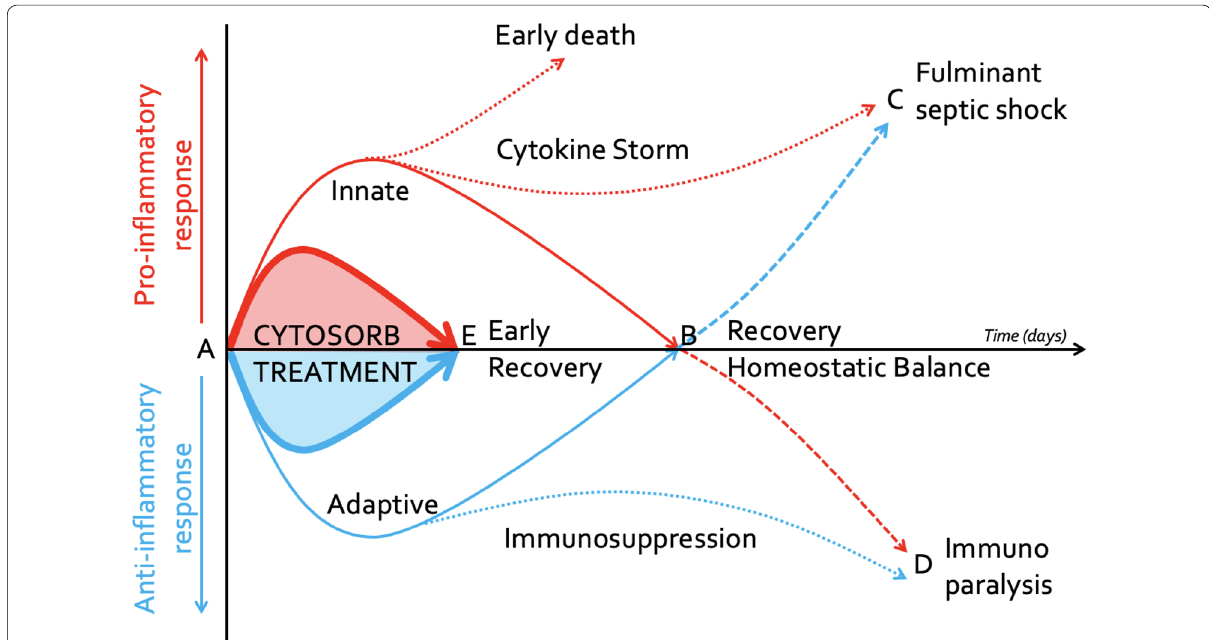
Fig. 1 Cytokine response after sepsis. Normal and abnormal immune response after an (infectious) insult (A). Recovery with regaining of the homeostatic balance occurs when pro‑inflammatory (solid red line) and anti‑inflammatory (solid blue line) mediators (B) return back to baseline levels. Early death or fulminant septic shock (C) can occur following early increased innate pro‑inflammatory response (cytokine storm, dotted red line) or after initial adaptive immunosuppression (dashed blue line). Immunoparalysis (D) can occur following early increased adaptive anti‑inflammatory response (immunosuppression, dotted blue line) or after initial pro‑inflammatory response (dashed red line). Haemoadsorption with Cytosorb ® may attenuate the initial pro‑ (bold red line) and anti‑inflammatory (bold blue line) response resulting in early recovery